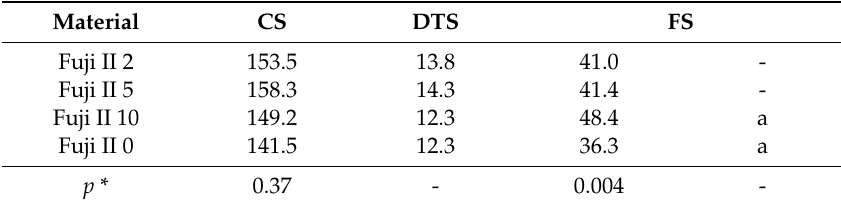
Table 5. Results of the ANOVA test for Fuji II.